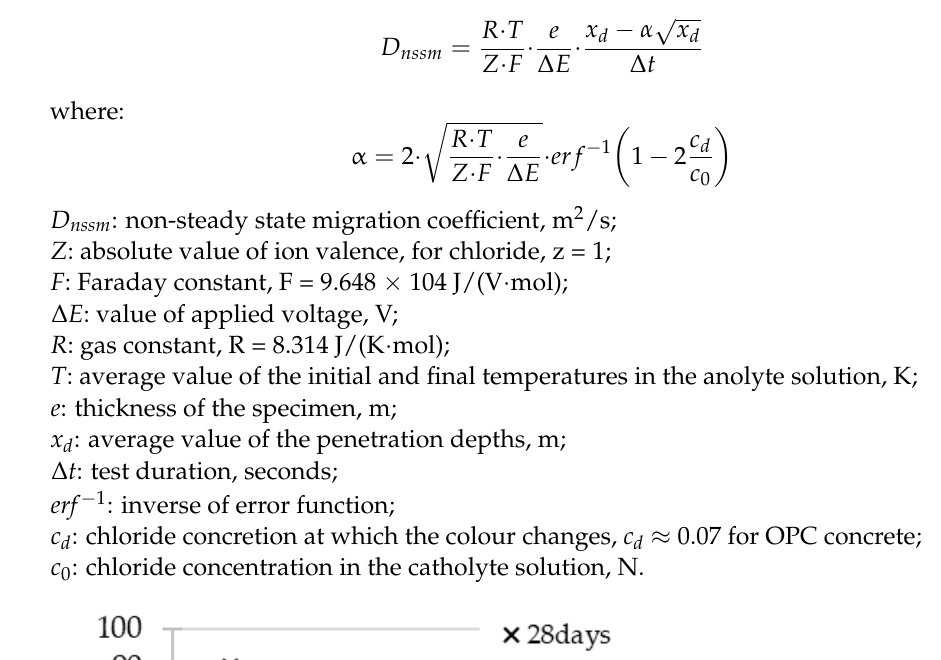
Figure 8. AACs’ chloride diffusion coefficient values vs. fc.